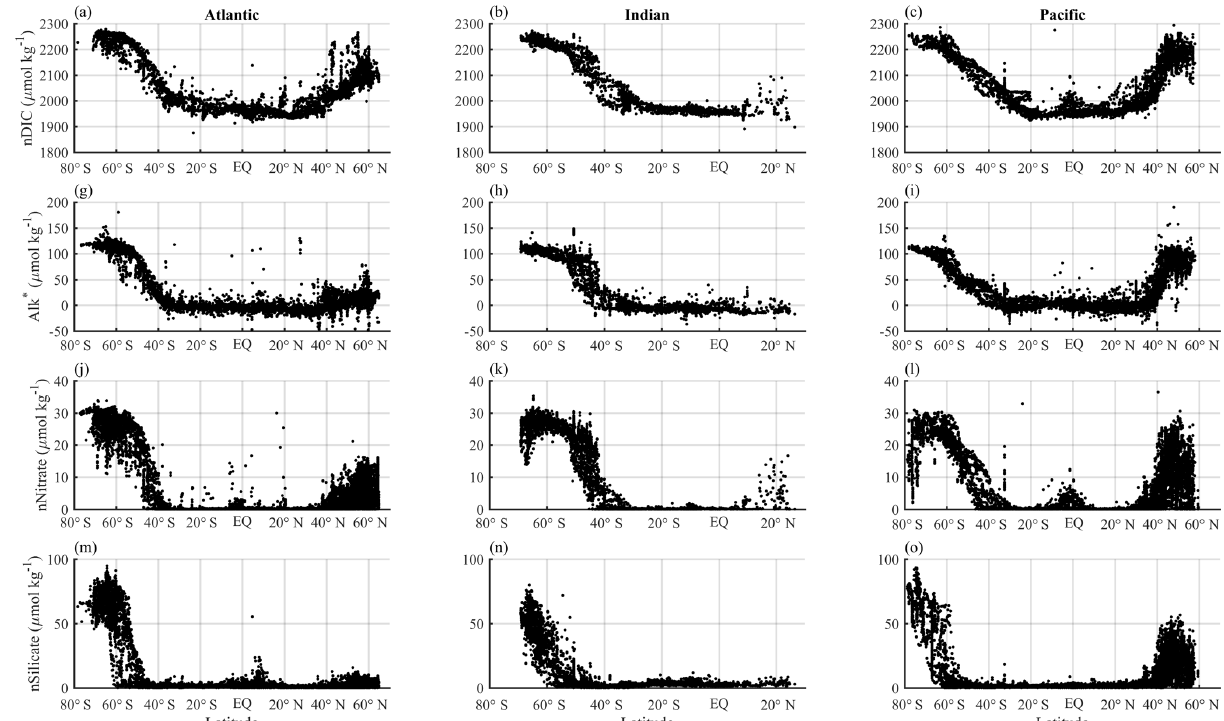
Figure 10. Latitudinal distributions of sea surface nDIC, Alk ∗ (Fry et al., 2015), salinity-normalized nitrate, and silicate in each ocean